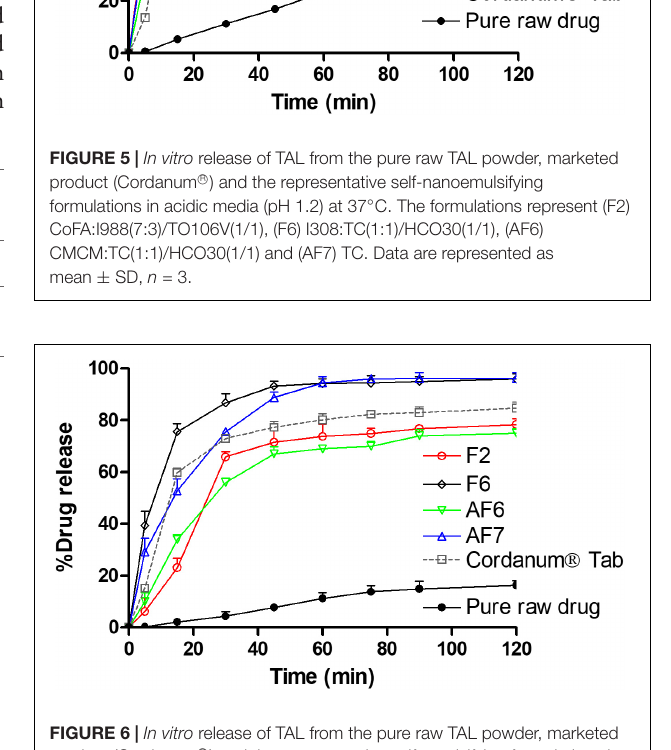
FIGURE 6 | In vitro release of TAL from the pure raw TAL powder, marketed product (Cordanum R (cid:13) ) and the representative self-emulsifying formulations in (pH 6.8) at 37 ◦ C. The formulations represent (F2) CoFA:I988(7:3)/TO106V(1/1), (F6) I308:TC(1:1)/HCO30(1/1), (AF6) CMCM:TC(1:1)/HCO30(1/1) and (AF7) TC. Data are represented as mean ± SD, n =